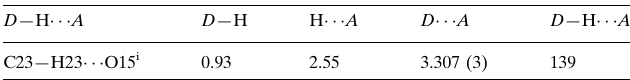
Hydrogen-bond geometry (A˚ , (cid:1)